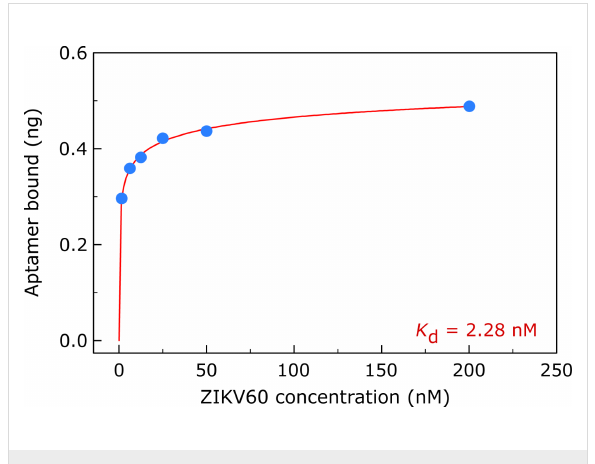
Figure 2: Dissociation constant ( K d ) of the ZIKV60 aptamer measured by ELONA. The saturation curve was obtained by plotting the aptamer concentration as a function of the total mass of ssDNA bound to ZIKV NS1. The value of K d was calculated by non-linear regression analysis (one-site specific binding with Hill slope, software GraphPad Prism 5), resulting in K d = 2.28 ± 0.28 nM (R 2 = 0.9958).